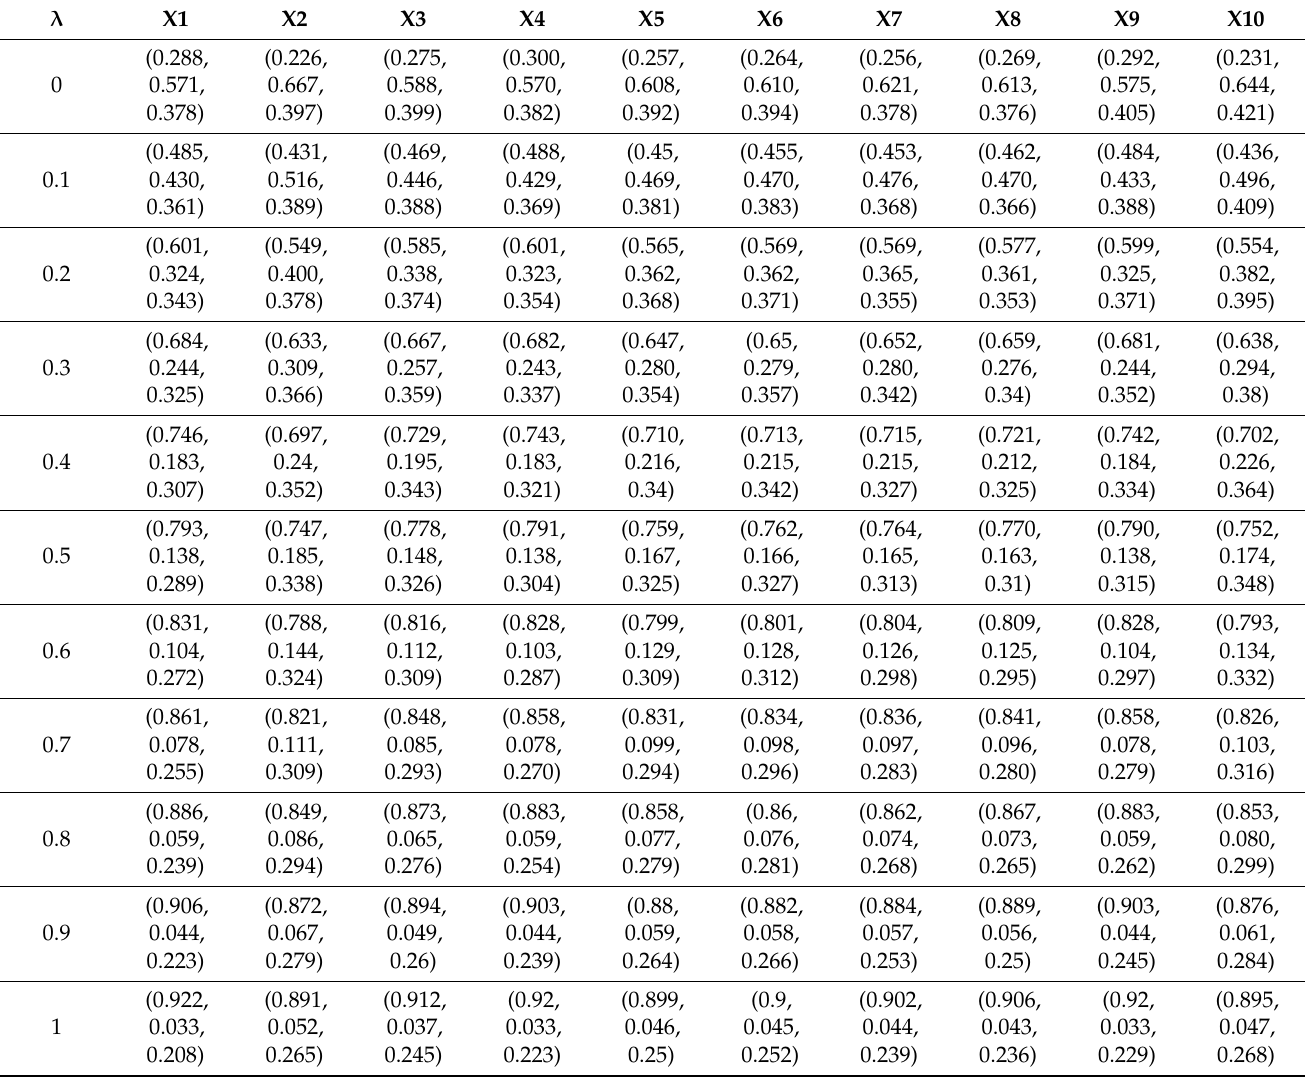
Table 15. Results of SF- WASPAS in terms of